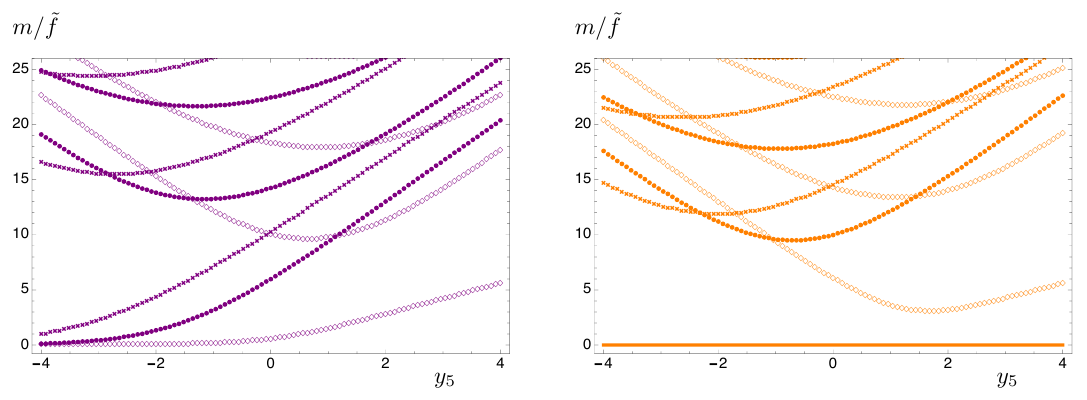
Figure 5 . Model II. Fermionic spectrum as a function of y 5 for ∆ R = 1 . 51 , 2 . 5 , 4 (diamonds, dots, crosses), ∆ = 3 , x F = 1 , g 5 = 8 , ∆ φ = 1 , φ c = 1 . 5 , r 1 = 10 − 12 , r 2 = 15 . The left and right panels correspond to imposing (+) and ( − ) IR boundary conditions, respectively. All plots are normalised to the decay constant ˜ f . The solid line in the right panel indicates the presence of a massless